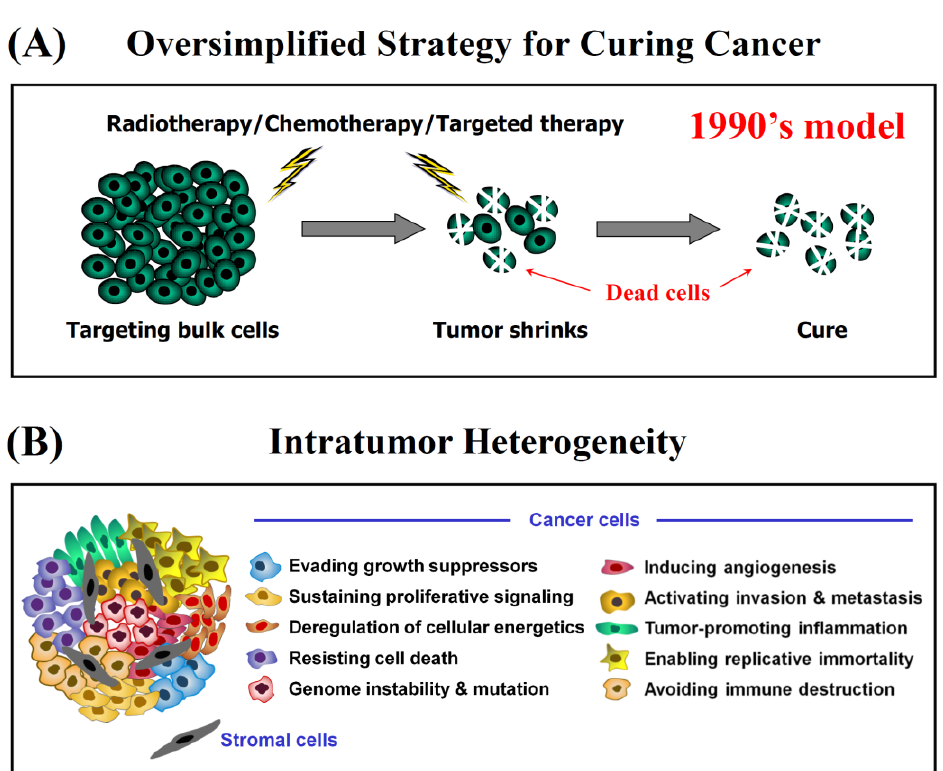
Figure 2. ( A ) Oversimplified (old) strategy for eradicating solid tumors through repeated doses of radiotherapy, chemotherapy, and other means (e.g., targeted therapies) when used singly or in various combinations; ( B ) Complex heterogeneity within an individual solid tumor (adapted from [91]).